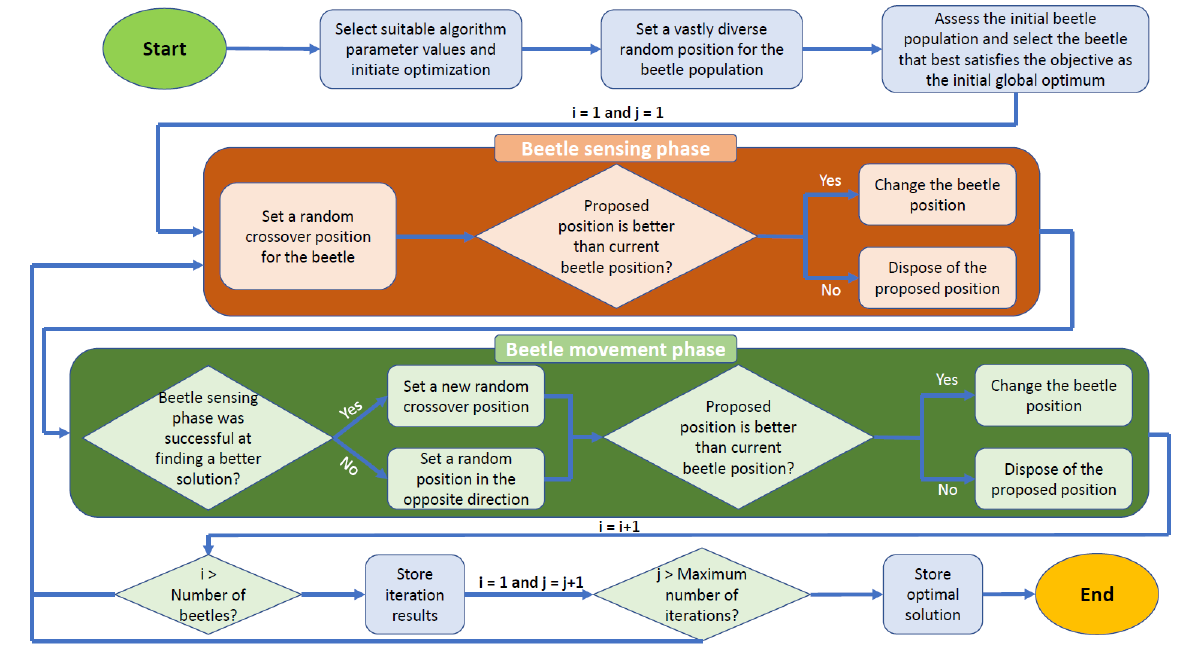
Figure 8. Flow chart of pbBAS algorithm.